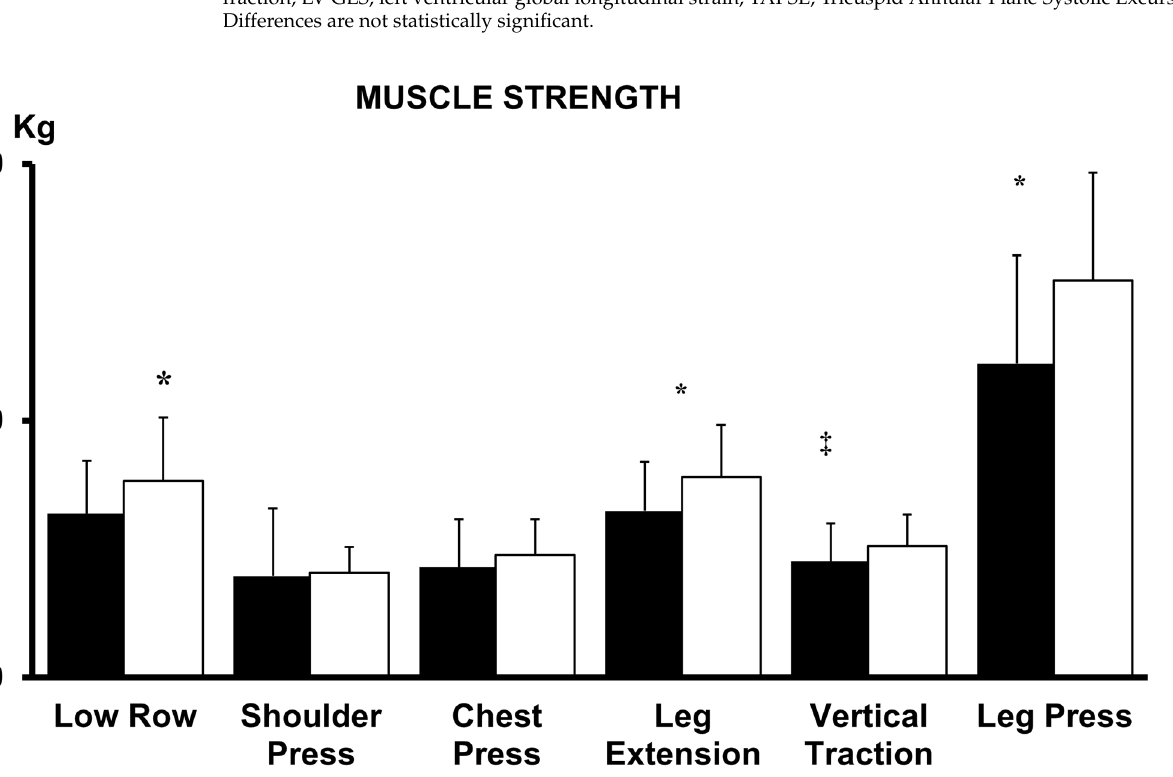
Figure 1. Muscle strength at baseline (black bars) and after 12 weeks of training (white bars) in CT group. ( ‡ p < 0.01, * p < 0.001 versus baseline, Low Row, ES = 0.55; Shoulder Press, ES = 0.07; Chest Press, ES = 0.27; Leg Extension, ES = 0.66; Vertical Traction, ES = 0.43; Leg Press ES = 0.76).